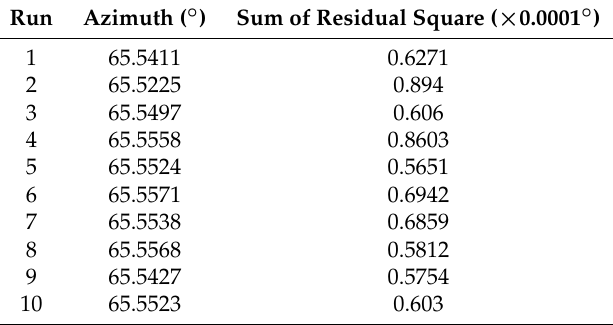
Table 2. Azimuth measurement results with n =